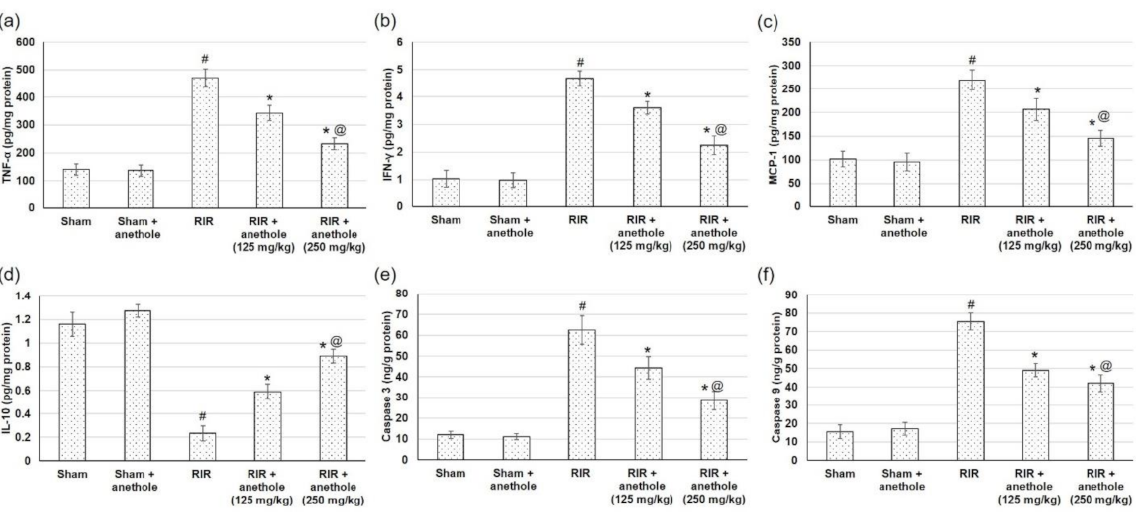
Figure 8. Effects of anethole (125 and 250 mg/kg) administration for 14 days prior to renal ischemia perfusion (RIR) on the renal inflammatory mediators ( a ) TNF- α , ( b ) IFN- γ , ( c ) MCP-1, and ( d ) IL-10, and on apoptosis, including ( e ) caspase 3 and ( f ) caspase 9, in RIR-induced injury. All values are stated as mean ± SD. # designates statistically significant compared to sham group, * designates statistically significant compared to RIR group, and @ designates statistically significant compared to RIR + anethole 125 mg/kg group ( p < 0.05) using one-way ANOVA followed by Tukey’s post hoc